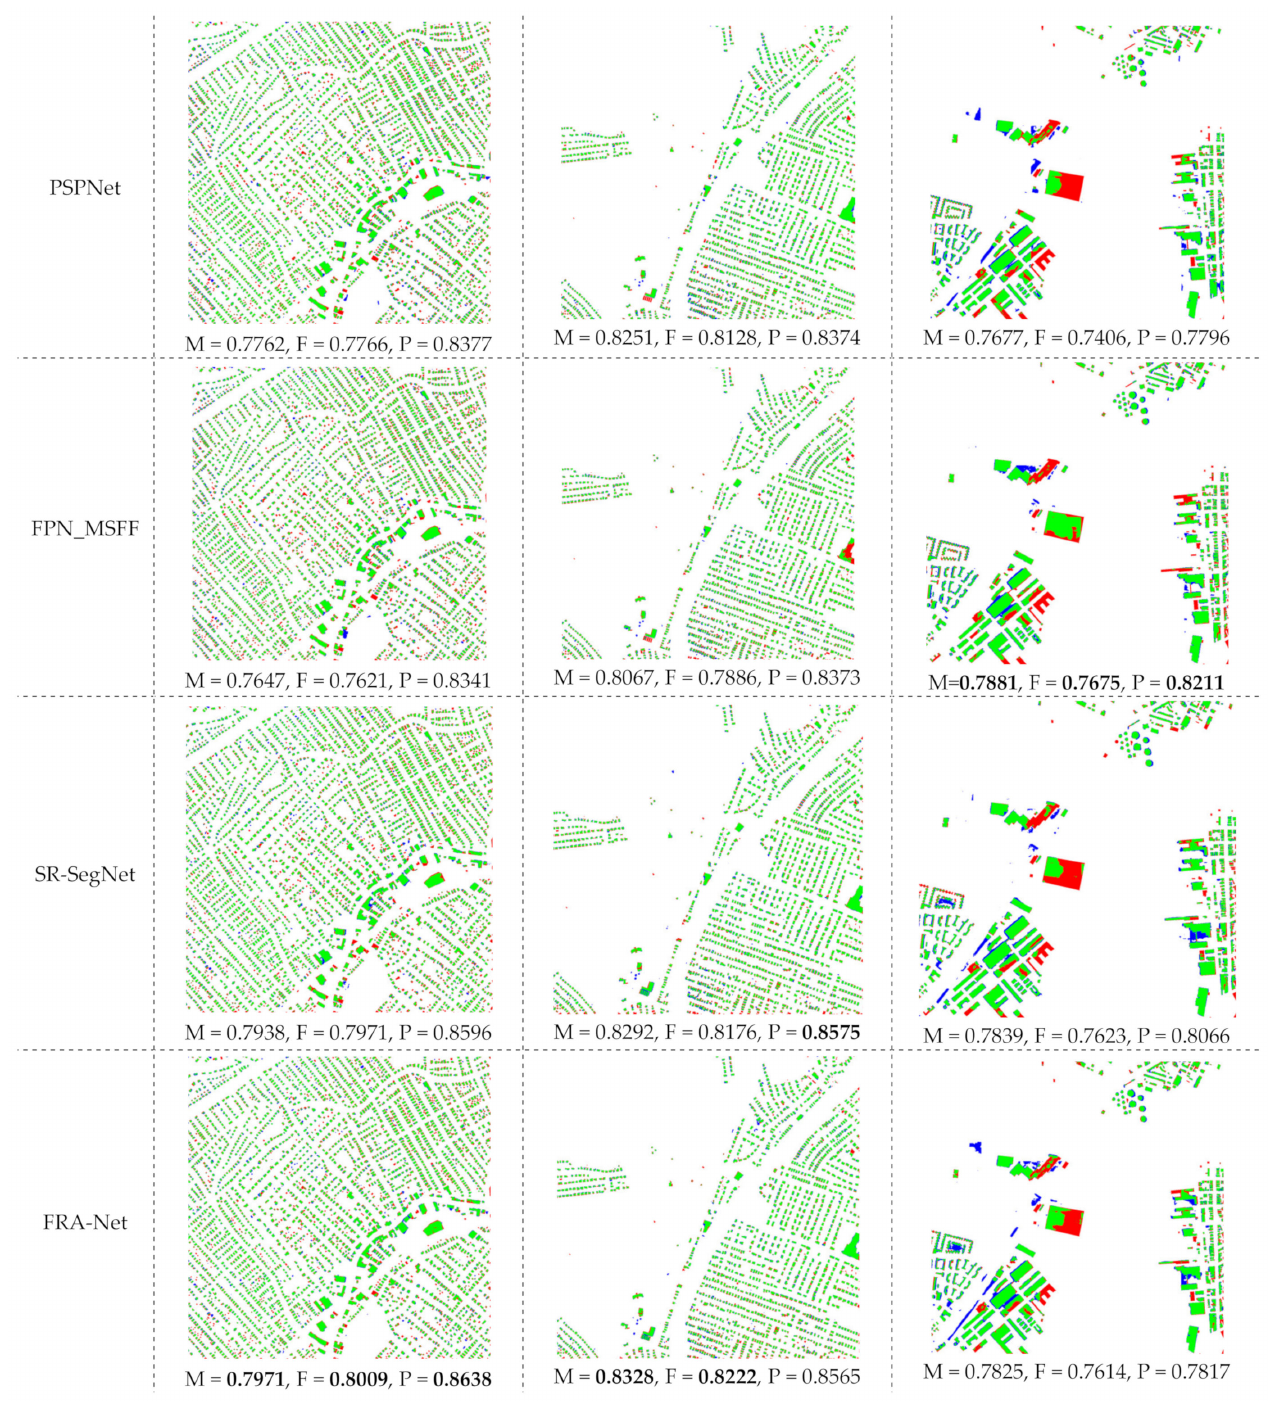
Figure 8. Comparison of the prediction results of each model in different regions of the Massachusetts building dataset. In the figure, green represents true-positive (predicted as a building, actually a building), blue represents false-positive (predicted as a building, actually a non-building), white represents true-negative (predicted as a non-building, actually a non-building), and red represents false-negative (predicted as a non-building, actually a building). ( a ) Residential area; ( b ) Rural area; ( c ) Complex